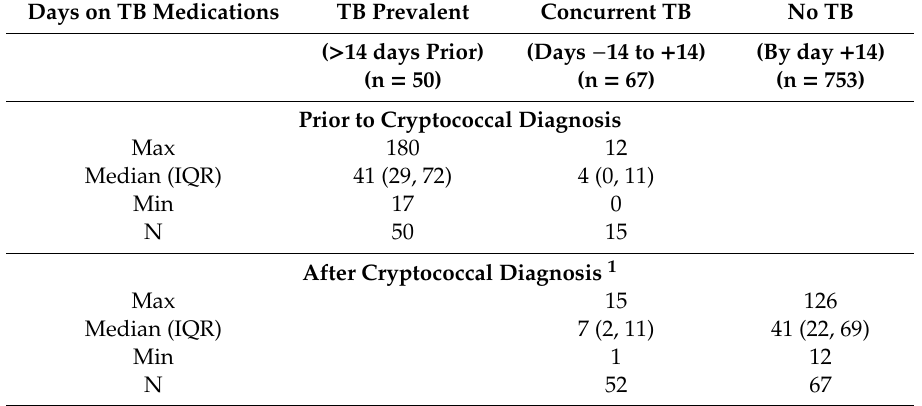
Table 2. Timing on antitubercular medication versus cryptococcal meningitis diagnosis.